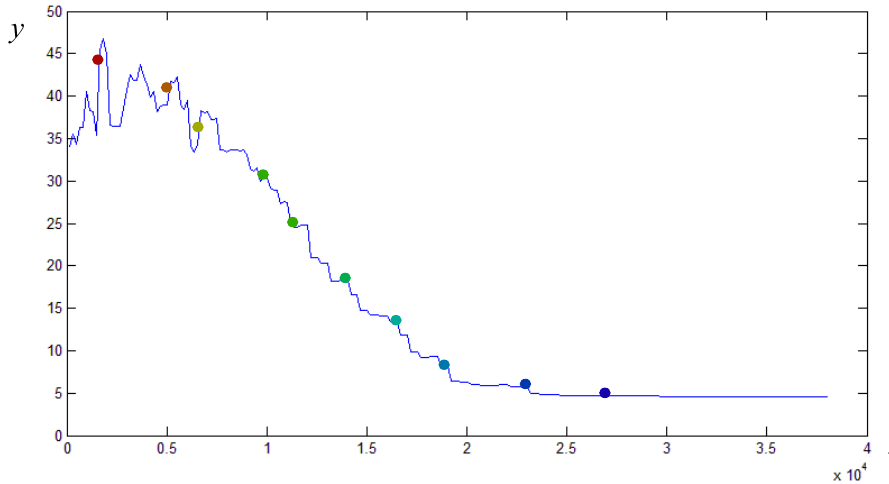
Figure 6. Optimization process: Evolution of the object configuration from the initial temperature (dark red) to the final one (dark blue) with the energy decreasing shown in Figure 7.